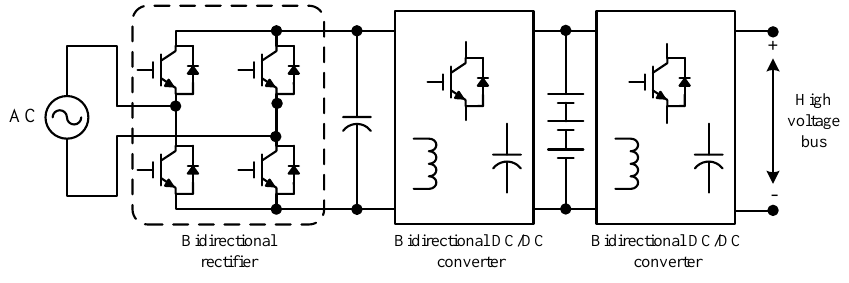
Figure 2. Electric charging system for V2G of EV.